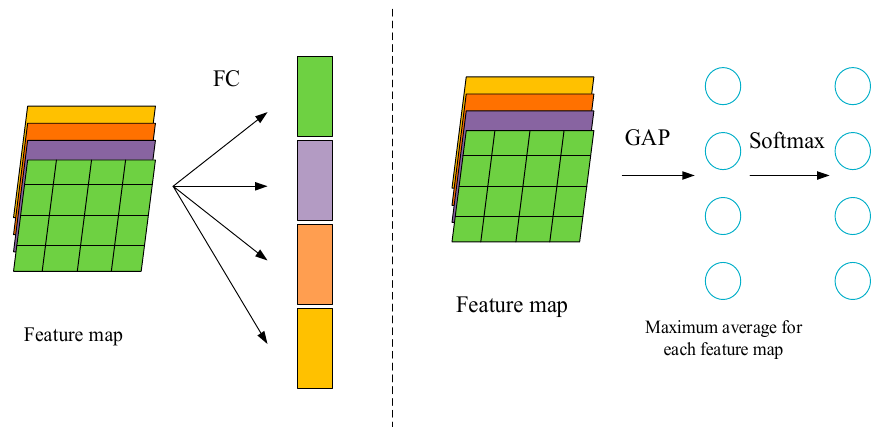
Figure 4. Comparison of the fully connected layer and the global averaged pooled layer.